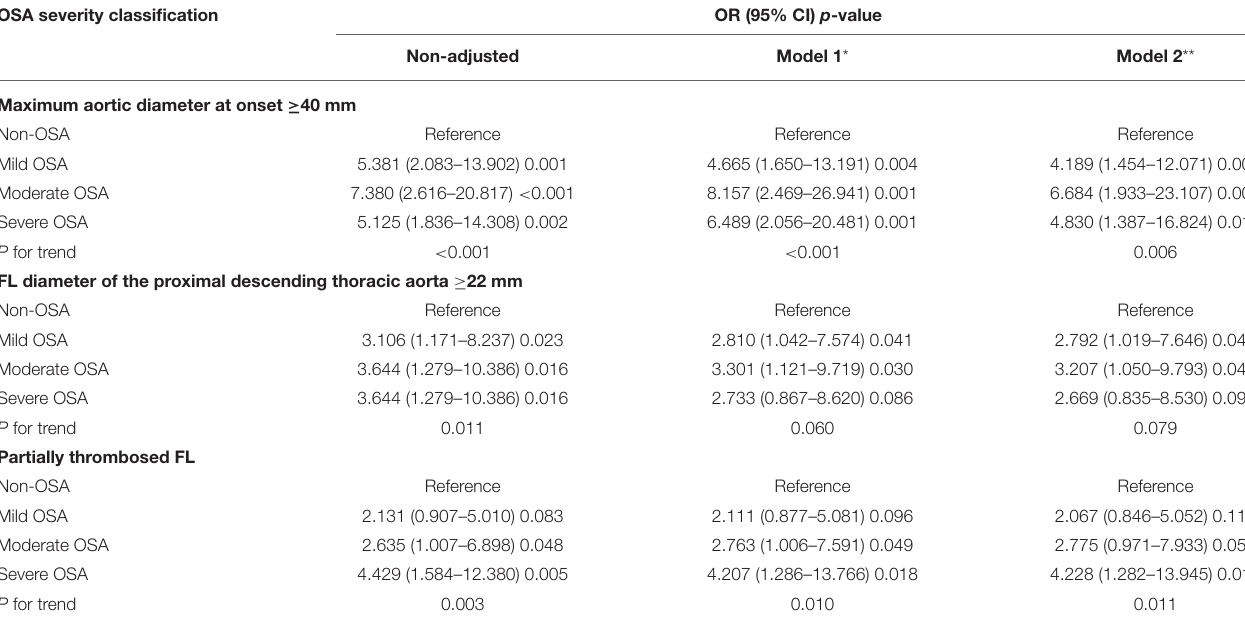
TABLE 4 | Logistic regression and trend analyses of imaging signs related to LAEs for different OSA